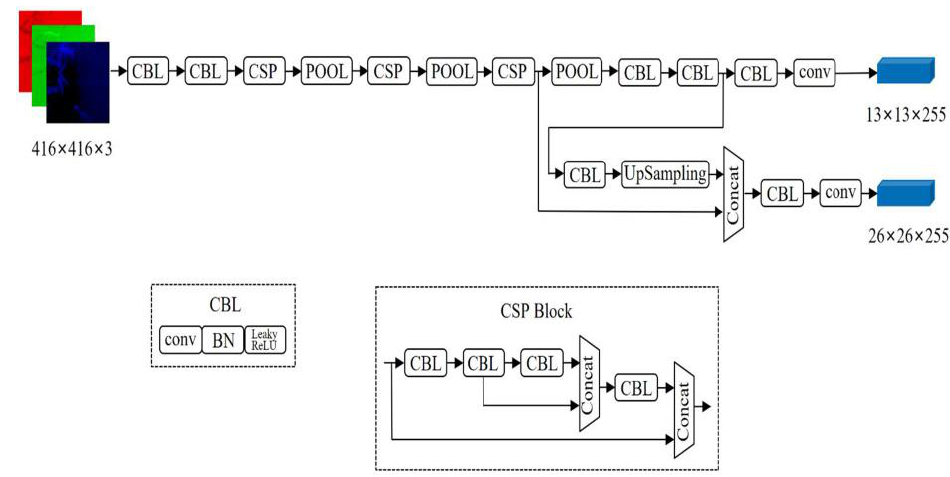
Figure 8. Structure of YOLOv4-Tiny model.